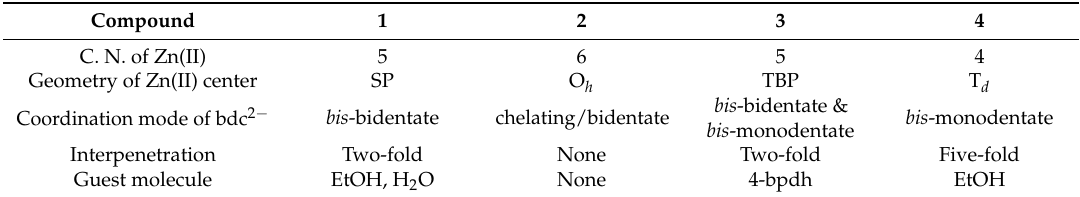
Table 2. Summary of structural characteristics in compounds 1 – 4 .